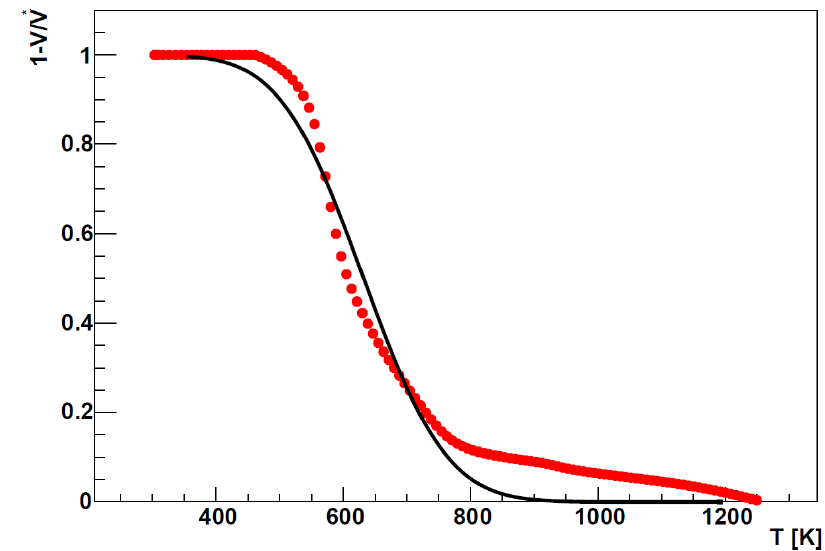
Figure 3. Comparison between the biomass experimental data (red points) and the 1-DAEM fitting (black line) at 20 K·min −1